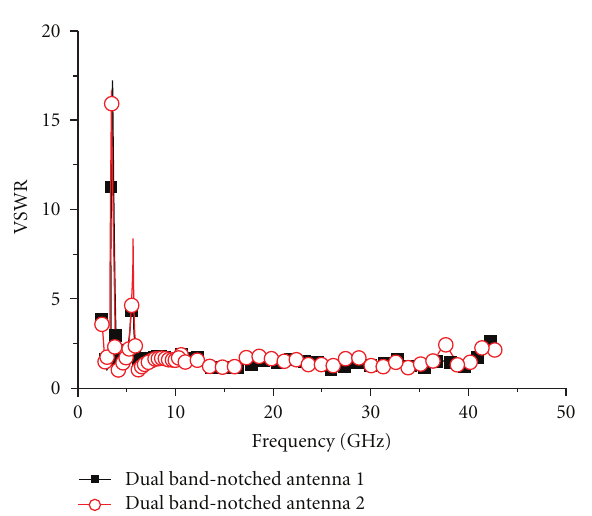
Figure 5: The simulated VSWR results of the dual band-notched antennas.